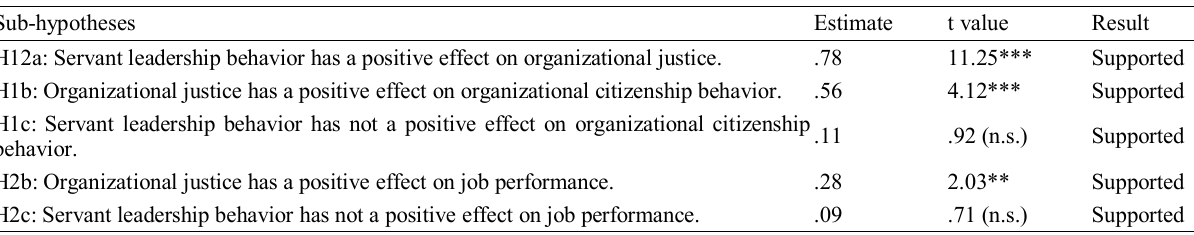
Table 3.Structural equation model